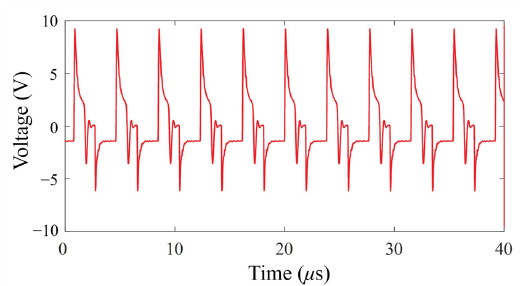
Figure 18. PV module breakage signals .